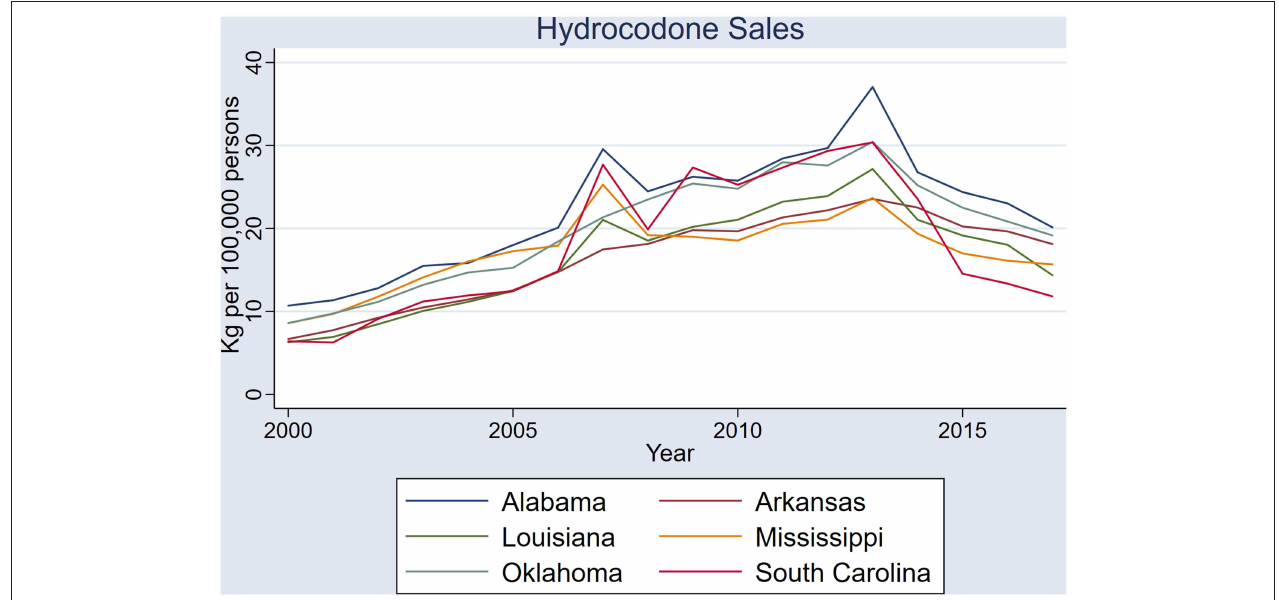
FIGURE 6 | Sales of oxycodone (kilograms per 100,000 persons) in the six states: Alabama, Arkansas, Louisiana, Mississippi, Oklahoma, and South Carolina.